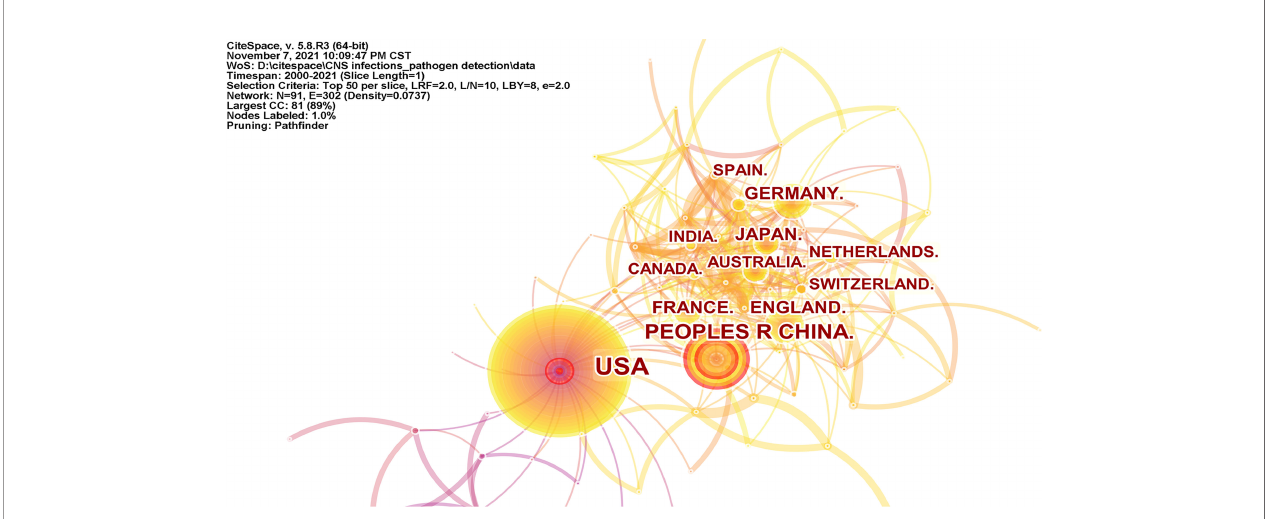
FIGURE 7 | Visualization map of the scienti fi c collaboration network analysis among countries/regions.